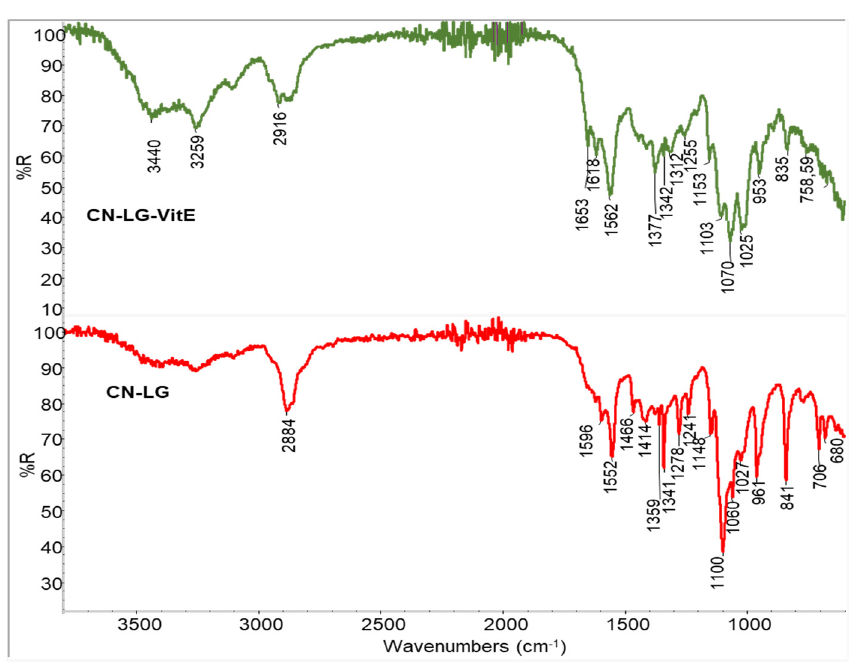
Figure 3. ATR spectra of chitin nanofibrils–nanolignin–Vitamin E complex (CN-LG-Vit-E) and chitin nanofibrils–nanolignin complex (CN-LG).